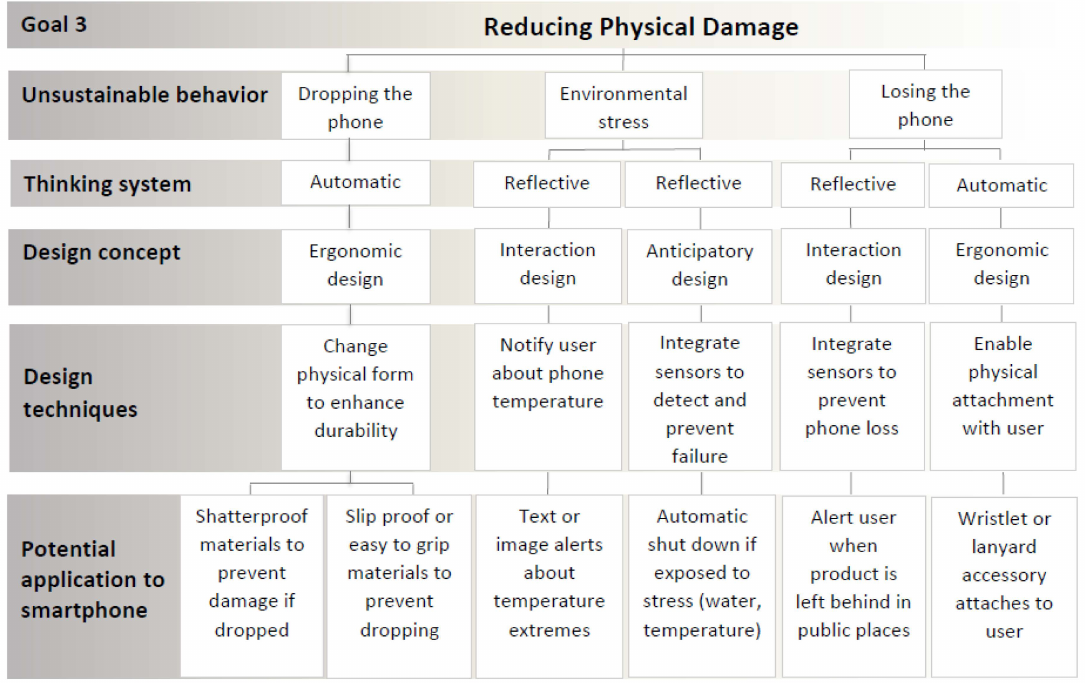
Figure 5. SBD framework applied to meet Goal 3, “Minimizing Physical Damage”: examples of how materials, sensors, or accessories can prevent damage or misplacement and extend product